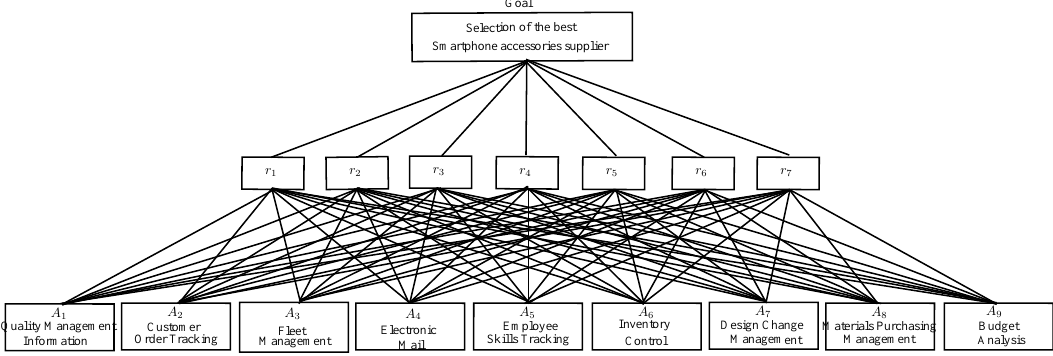
Figure 12: The optimal project selection hierarchical structure. Figure 12. The optimal project selection hierarchical structure.